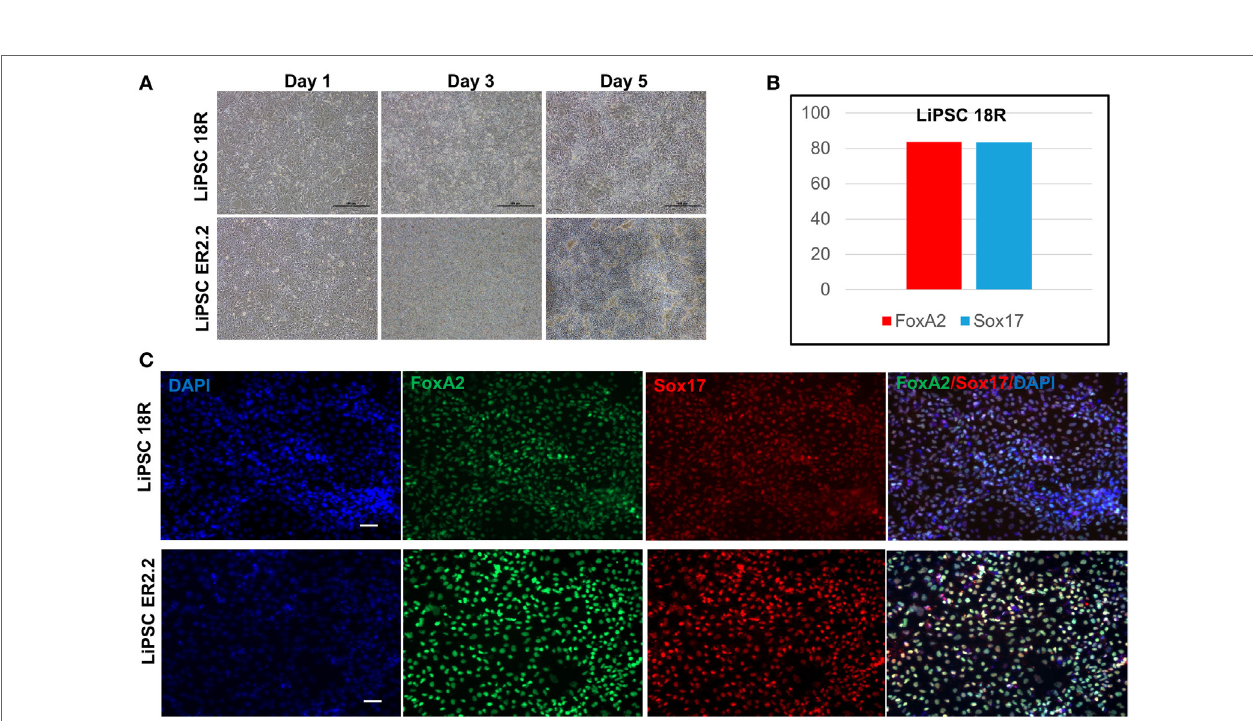
FigUre 5 | Differentiation of LiPSCs into definitive endoderm (DE). (a) Morphology of LiPSC-derived cells was changing during the differentiation from day 1 to day 5. The cells were highly proliferative during the differentiated period and produced dense single-layered sheets. (B) Flow-cytometry analysis at the end of day 5 demonstrated that more than 80% of LiPSC 18R-derived cells express FoxA2 and Sox17. (c) Immunofluorescent staining of day 5 cells on both lines revealed that they express DE-specific markers (FoxA2 and Sox17). Scale bar: 100 µm.